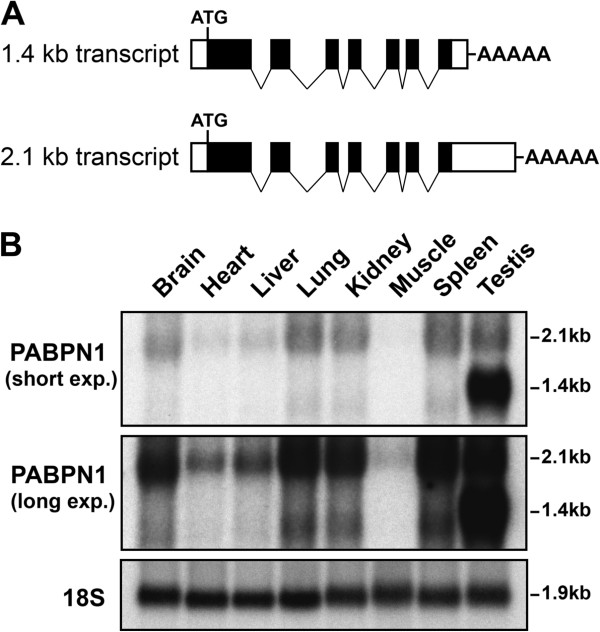
Nuclear poly(A) binding protein 1 (PABPN1) mRNA levels are low in skeletal
muscle. (A) Structure of the 2.1 kb and 1.4 kb PABPN1 transcripts (solid
boxes represent coding regions and open boxes non-coding regions). (B)
Total RNA from different mouse tissues was analyzed by northern blot using a
PABPN1 probe. Two different exposures, short and long, are shown. 18S rRNA was
probed as a loading control. Figure is representative of at least three
independent sets of tissues.